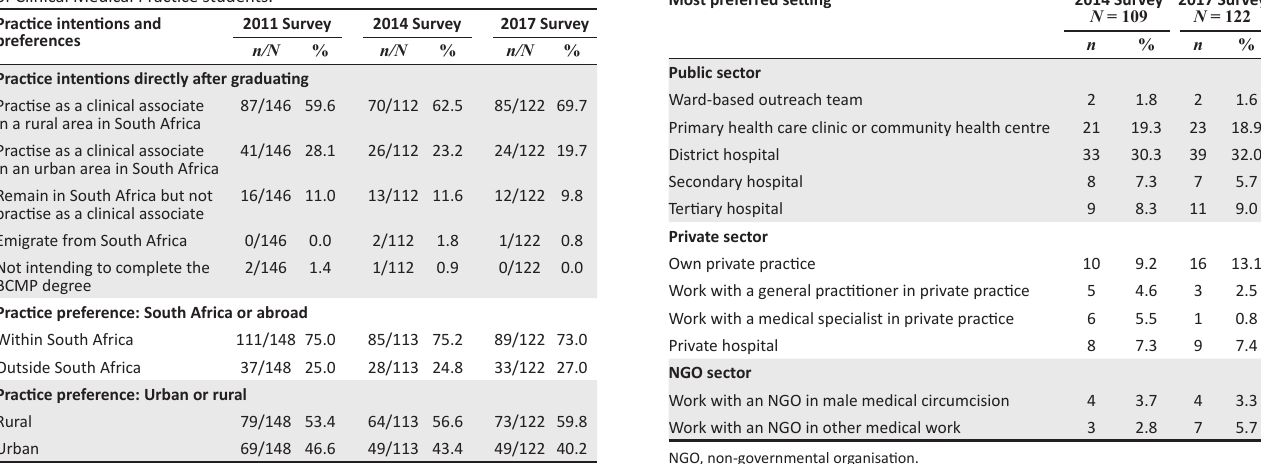
TABLE 3: Geographical practice intentions and practice preferences of Bachelor of Clinical Medical Practice students. Practice intentions and preferences